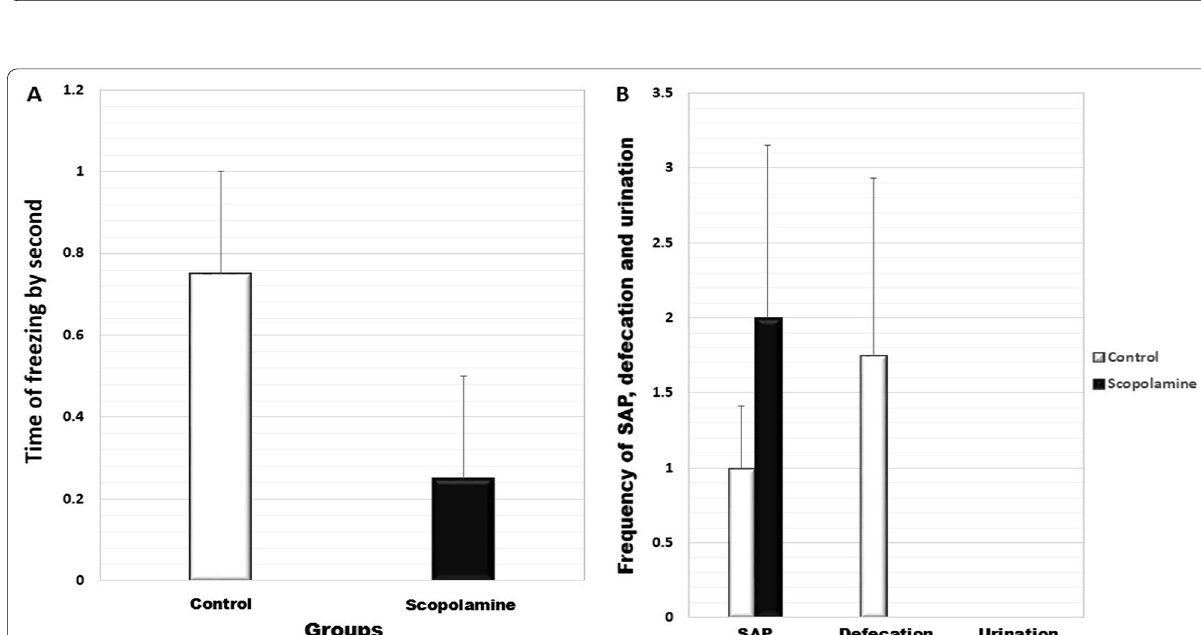
SE ( n 6). A significant difference ± =